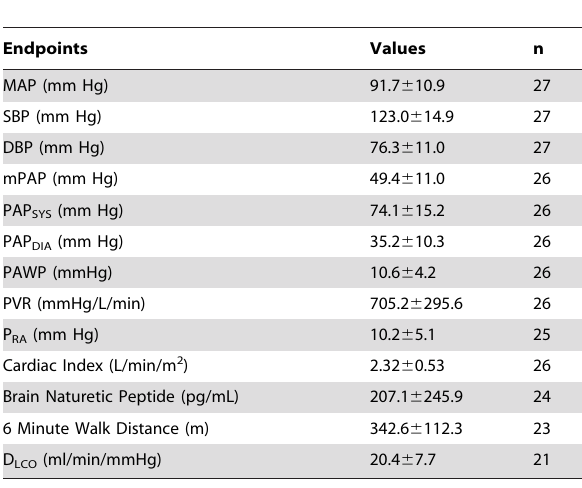
Table 2. Hemodynamic and clinical endpoints for IPAH